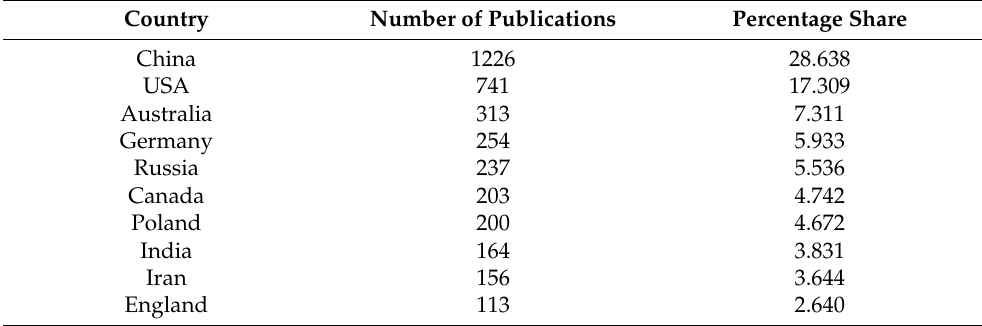
Table 1. Top 10 countries with the highest number of publications in Web of Science database.